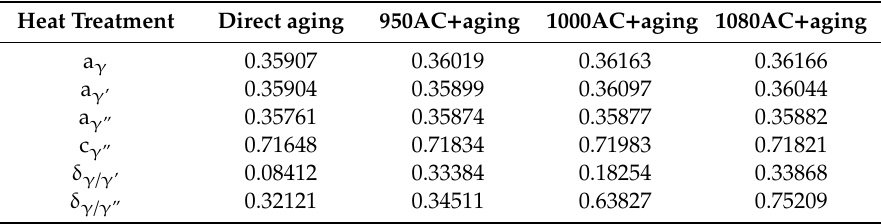
Figure 6. The powder X-ray diffraction (PXRD) patterns and corresponding Gaussian fitting results for the ( a ) DA, ( b ) 950AC+aging, ( c ) 1000AC+aging, and ( d ) 1080AC+aging samples. Table 2. Lattice parameters (nm), and misfit values δ (%) of γ , γ ’, and γ ’’ phases calculated on the basis of peak fitting of the XRD data.